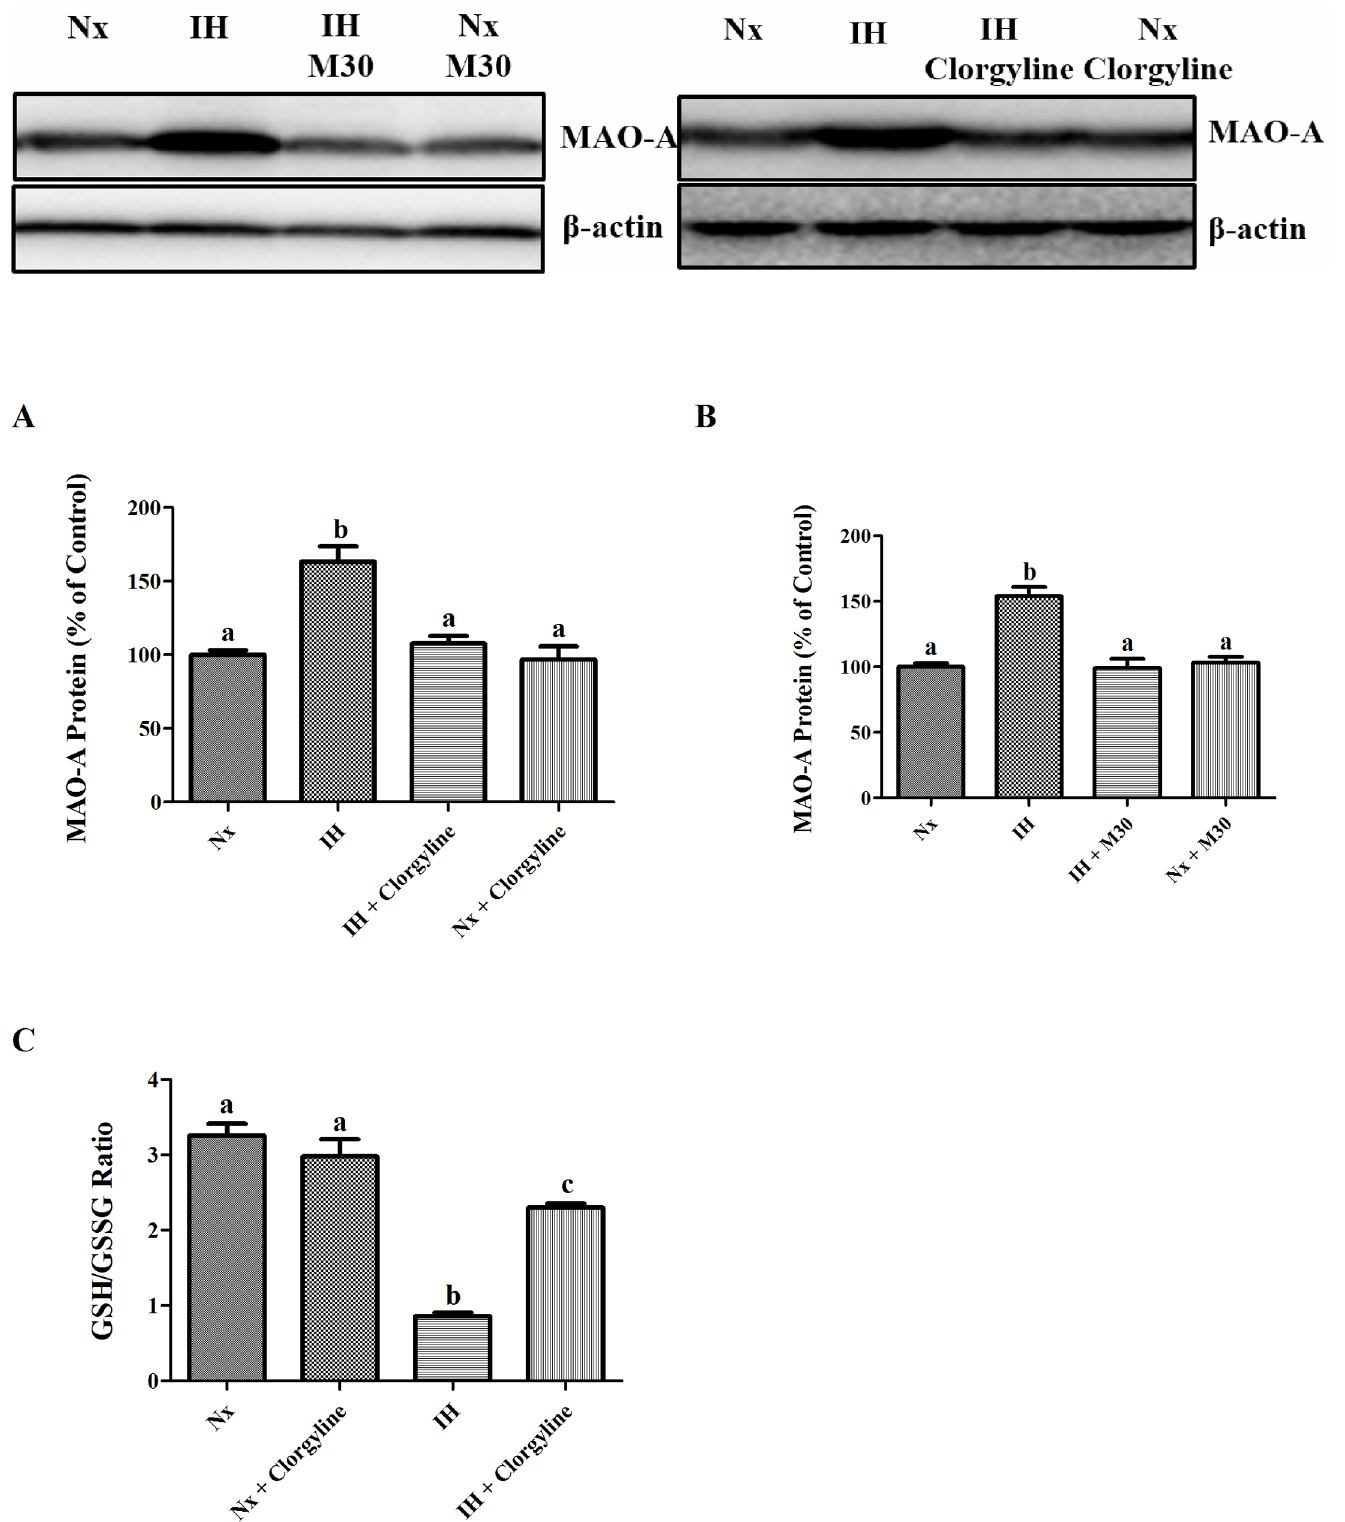
Fig 8. The level of protein expressionof MAO-A was increasedby exposureto intermittent hypoxia(IH) in SH-SY5Y cells, which was antagonized by M30 at 1 μ M or clorgyline at 10 μ M (Panel A and B). Hypoxia significantly reducedthe GSH/GSSG ratio in SH-SY5Y cells, which was partially attenuated by